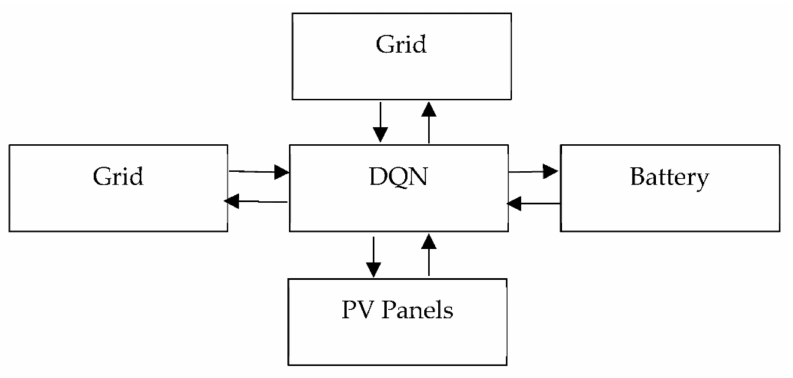
Figure 2. Microgrid